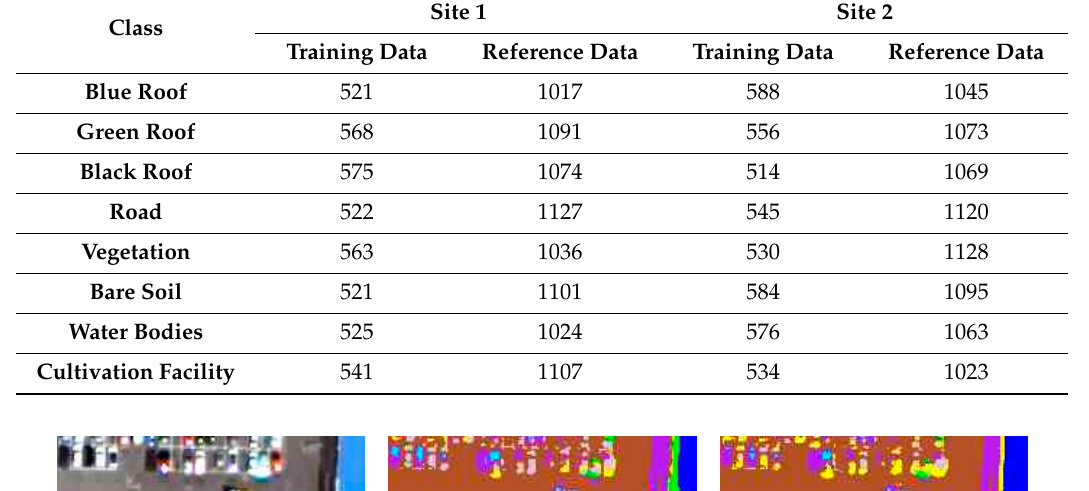
Table 3. Number of pixels in the training and reference data.